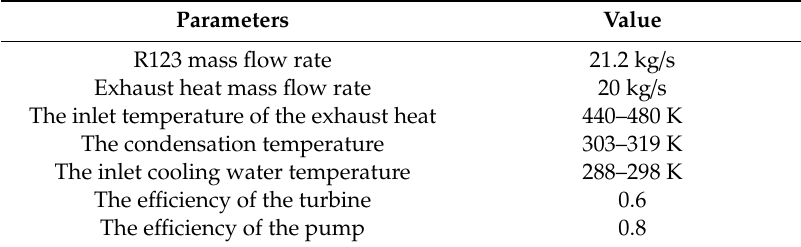
Table 1. Values of ORC system used for validation.